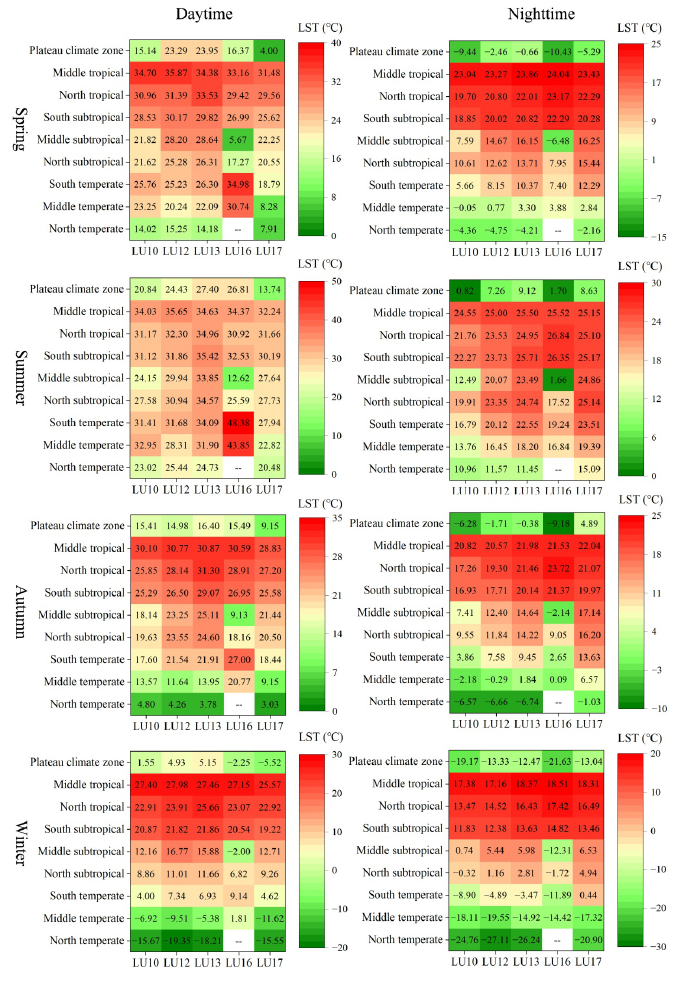
Figure 6. Distribution map of daytime and nighttime seasonal mean land surface temperatures (LSTs) of different land use/land cover (LULC) types in different climate zones of China. LU10, LU12, LU13, LU16, and LU17 represent grasslands, croplands, urban and built-up areas, barren land, and water bodies, respectively.